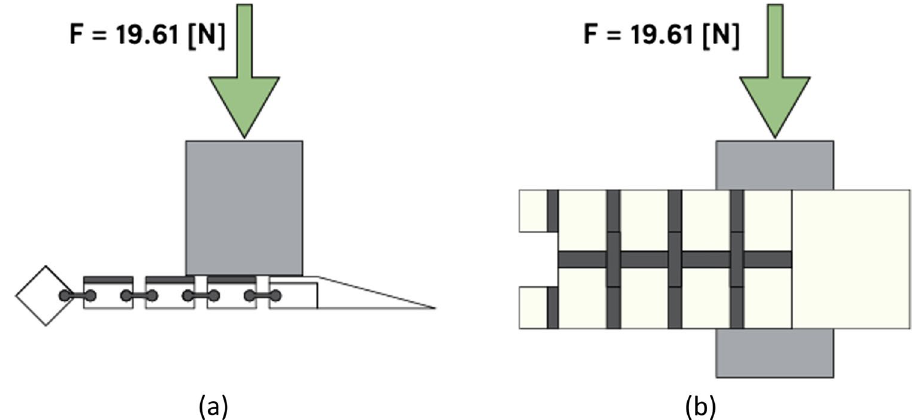
Fig. 9 FEM configurations: a first configuration; b second